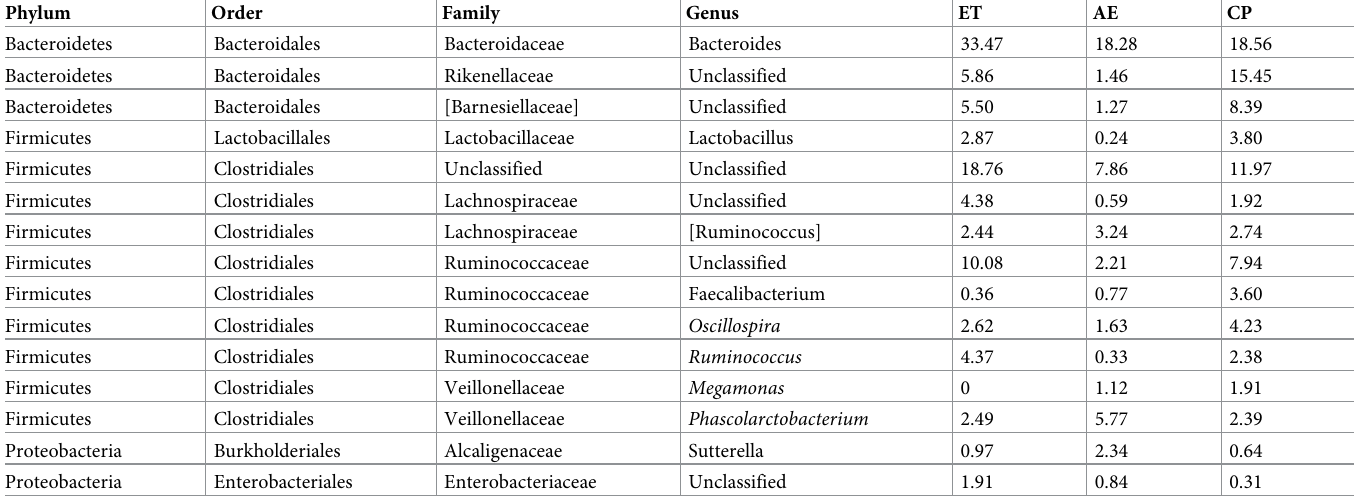
Table 5. List of shared OTUs among chicken cecal Argentine